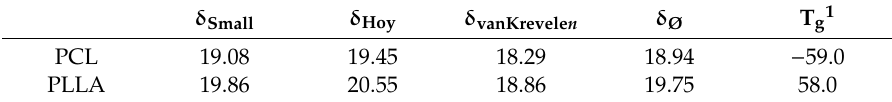
Table 1. Hildebrand solubility parameters δ of PCL / PLLA calculated by group additivity method [15– 17]. δ δ Hoy δ δ Ø T g1 Small vanKrevele n PCL 19.08 19.45 PLLA 1 measured by